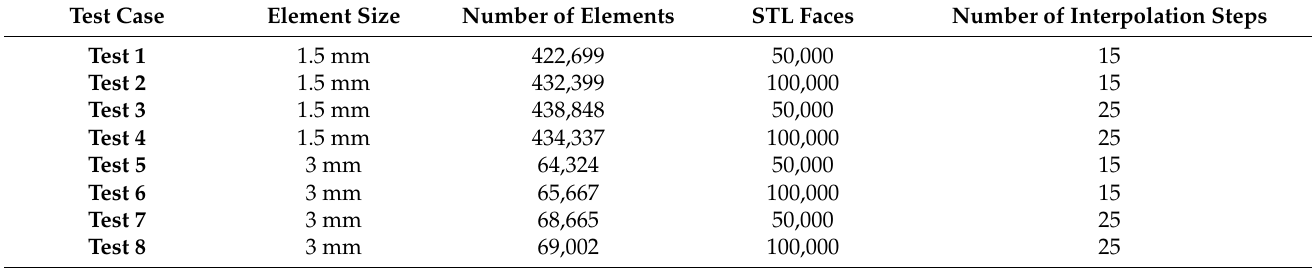
Table A2. Combinations of parameters used for the eight test cases generated for the timing analysis of the proposed workflow. The third column is not an input but the number of elements contained in the mesh automatically generated using the goal size specified by the second column. The fourth column is the goal number of faces specified (the final number of faces may deviate slightly from this number).